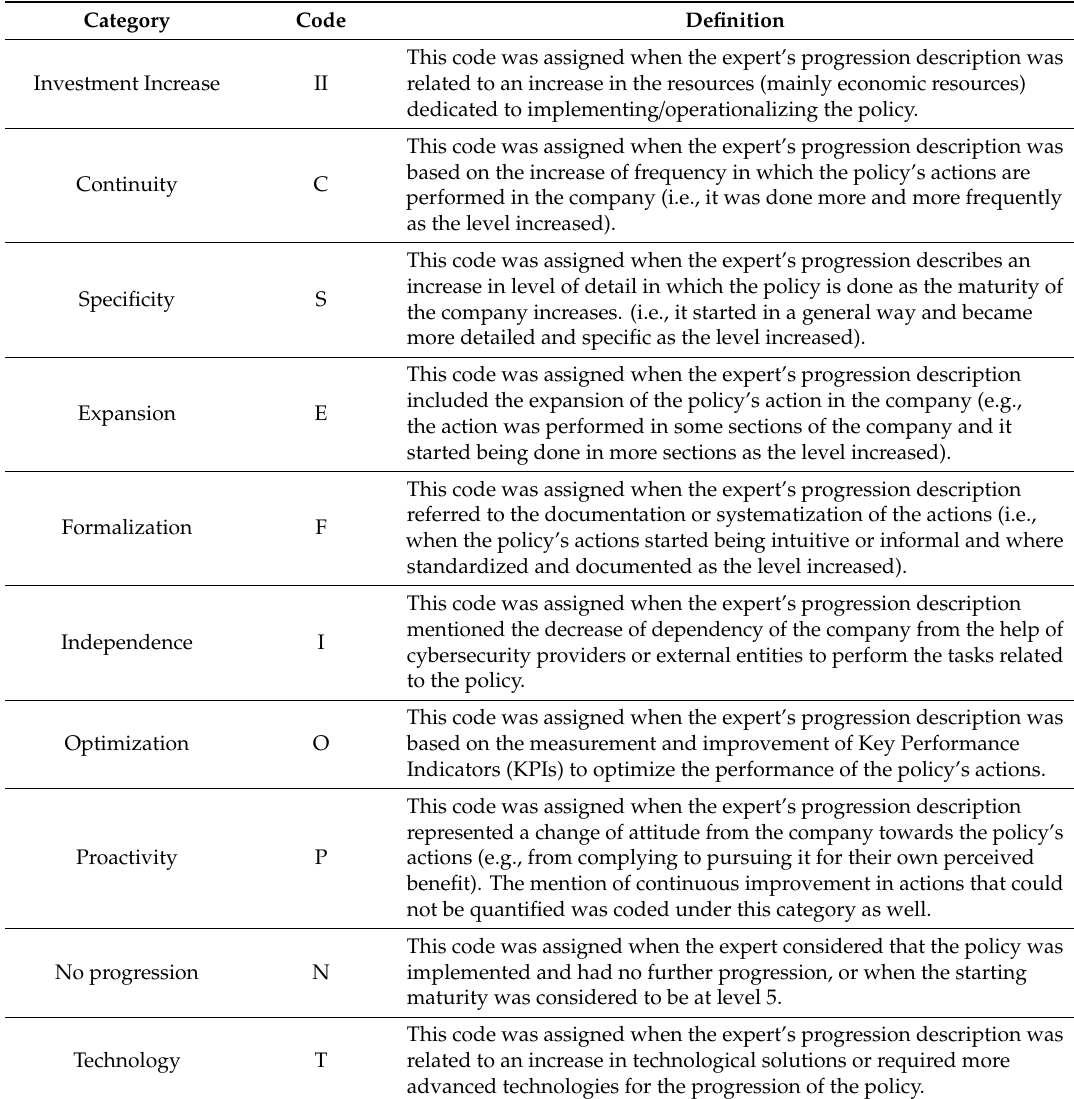
Table 1. Progression types for coding and their